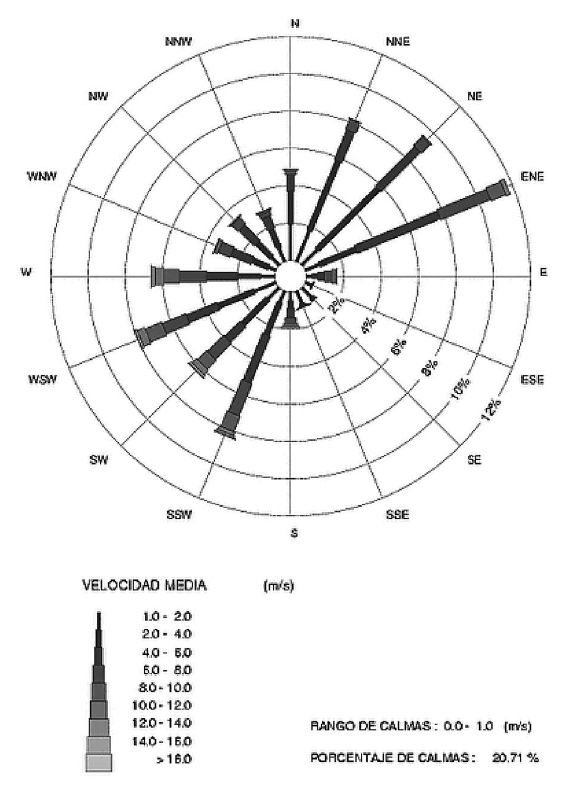
Fig . 5. – Current field on the first day of the Lagrangian simulation and location of the zones of release of the 1000 tracers. Zones 1, 2 and 3 correspond to the red, green and orange polygons, respectively.